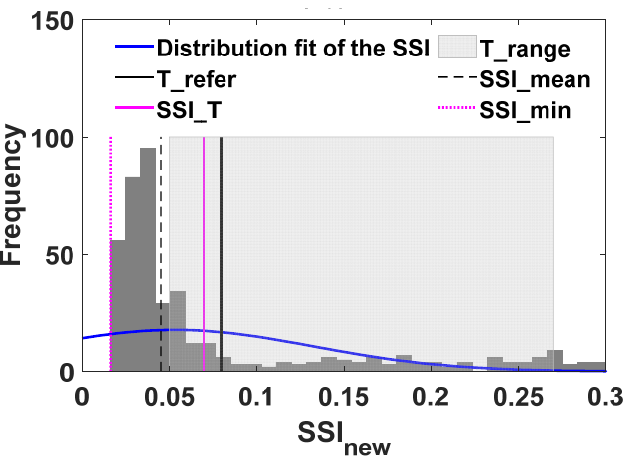
Figure 8. An example of the SSI new histogram at site 24 during late autumn to early spring.